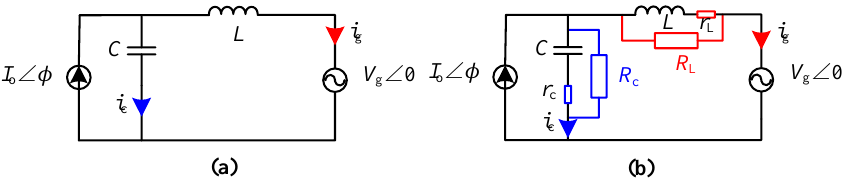
Figure 5. Equivalent circuit of CL filter: ( a ) CL filter without internal resistance and voltage Hall resistance; ( b ) CL filter with internal resistance and voltage Hall resistance.